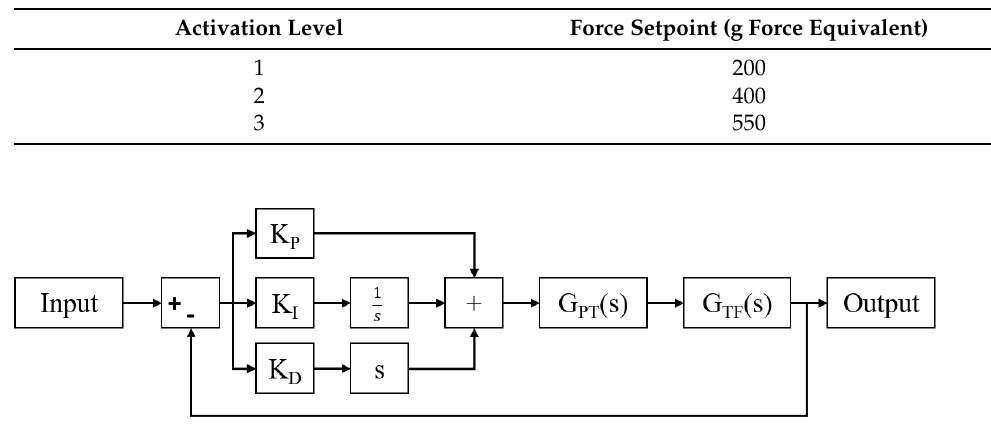
Table 9. Force setpoints used for controller tuning and testing purposes, based on the results of the force characterisation experiment, available in Figure 8.